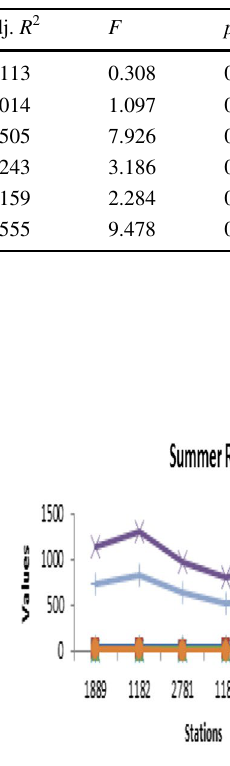
Table 3 One-way ANOVA calculations for summer season